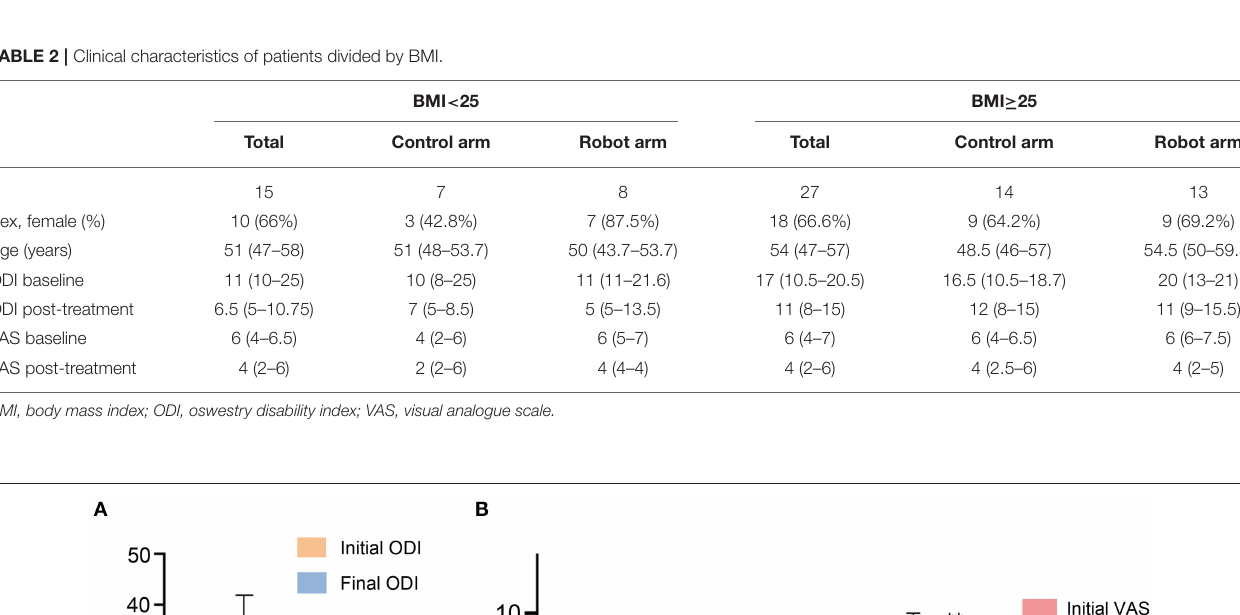
FIGURE 4 | Comparison of the ODI (A) and VAS (B) scales, before and after the treatment in both arms of the study, taking into consideration the sex of the patients. Values are expressed as box plots, which represent the interquartile range with the median as a horizontal line. Whiskers encompass the maximum and minimum values of the population. * p < 0.05, ** p < 0.01, compared to initial test.